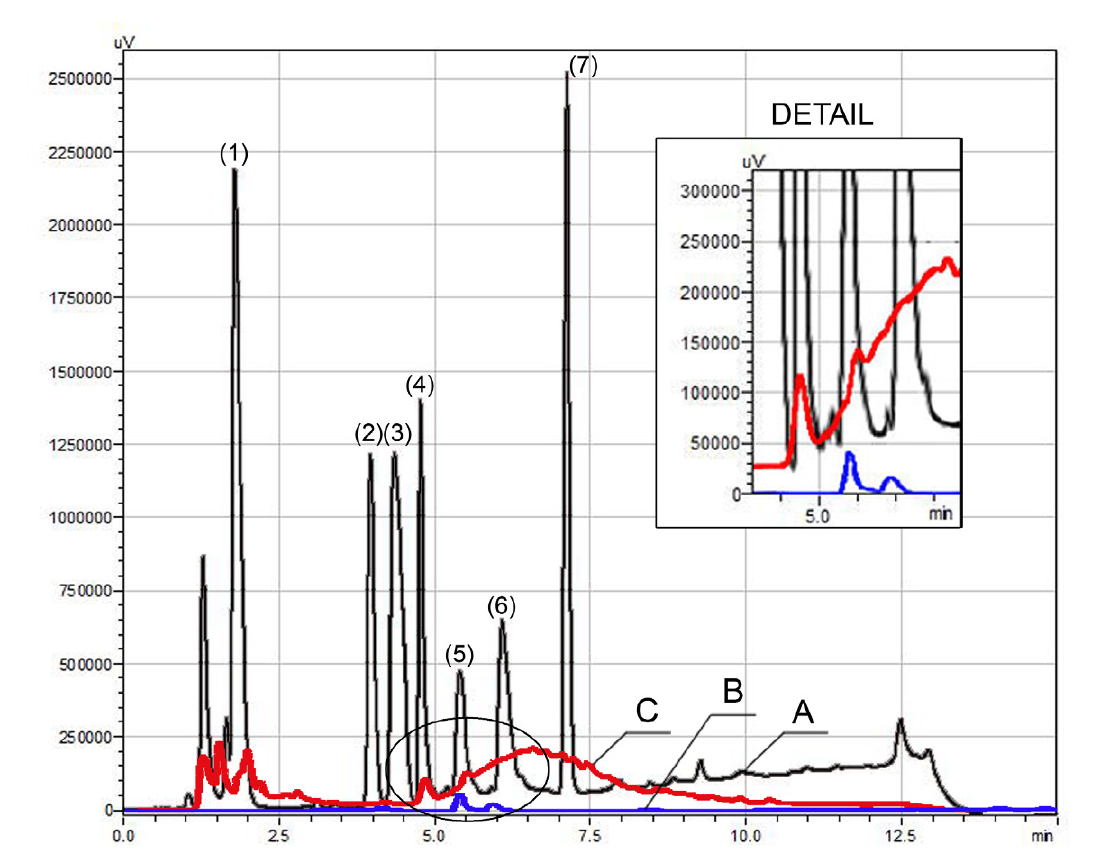
Figure 2. SPE-LC-DAD-ESI(+)-MS chromatograms of some waste water samples collected from WWTP: A - standard mixture of the studied antibiotics; B - influent at 9 o’clock; C - influent at 15 o’clock. Peak identification: (1) amoxicillin, (2) ceftazidime, (3) ampicillin, (4) ceftriaxone, (5) tetracycline, (6) doxycycline, (7) penicillin